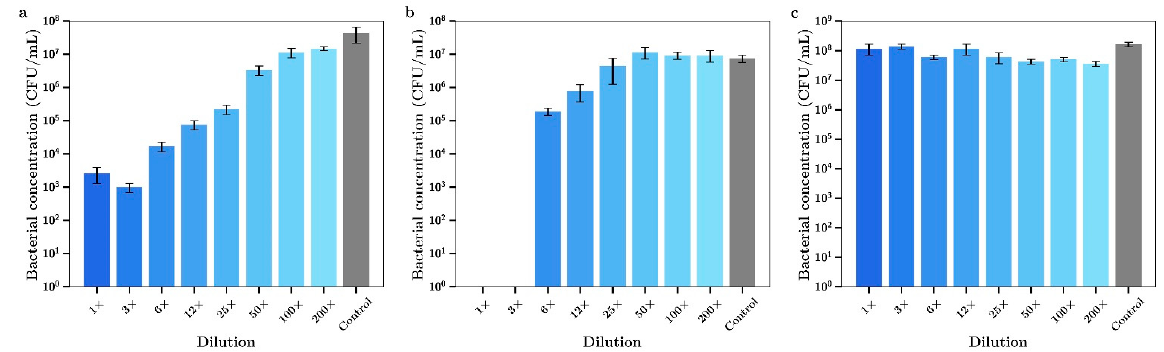
Figure 12. Bacterial concentrations of P. aeruginosa incubated in various dilutions of the 7-day incubation release media of bone cement containing ( a ) Ag, ( b ) Ag + tobramycin, ( c ) tobramycin. (Silver loaded at 0.8% and tobramycin at 0.8% w/w ) ( n = 3).